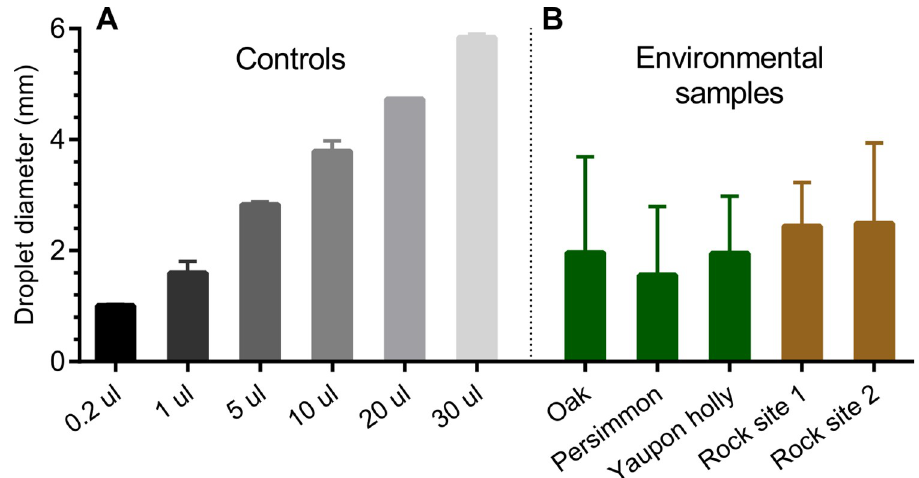
Fig 2. A comparison of diameters between laboratory experiments and samples collected from the outbreak in Texas. (A) Averages of droplet volume spotted onto petri dishes in controlled experiments. (B) Averages of fly droplets and emesis on leaves (12 spots from 7 yaupon leaves, 20 spots from 9 oak leaves and 6 spots from3 persimmon leaves) and rocks (10 spots from 2 rocks at site one and 10 spots from 3 rocks at site 2) collected during the 2019 anthrax outbreak in Texas where viable B . anthracis spores were